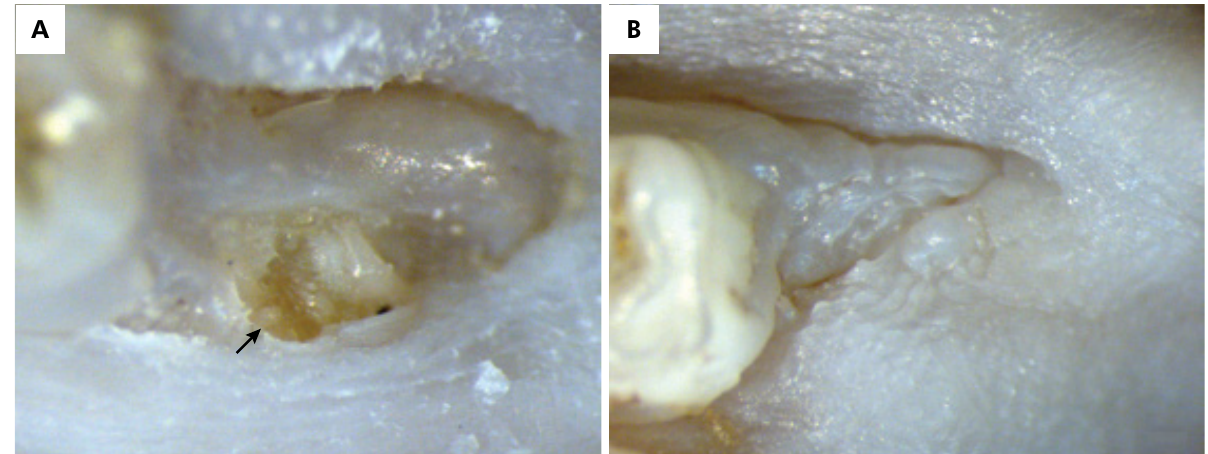
Figure 1. Clinical aspects of a lower first molar (M1) alveolar socket 28 days after tooth extraction. Animals treated with ALN (A) exhibited areas of exposed bone with a marked impairment of alveolar socket re-epithelialization. In contrast, animals treated with sterile physiological saline (B) presented a full epithelial lining on the alveolar socket, with no signs of inflammation or infection (asterisk).